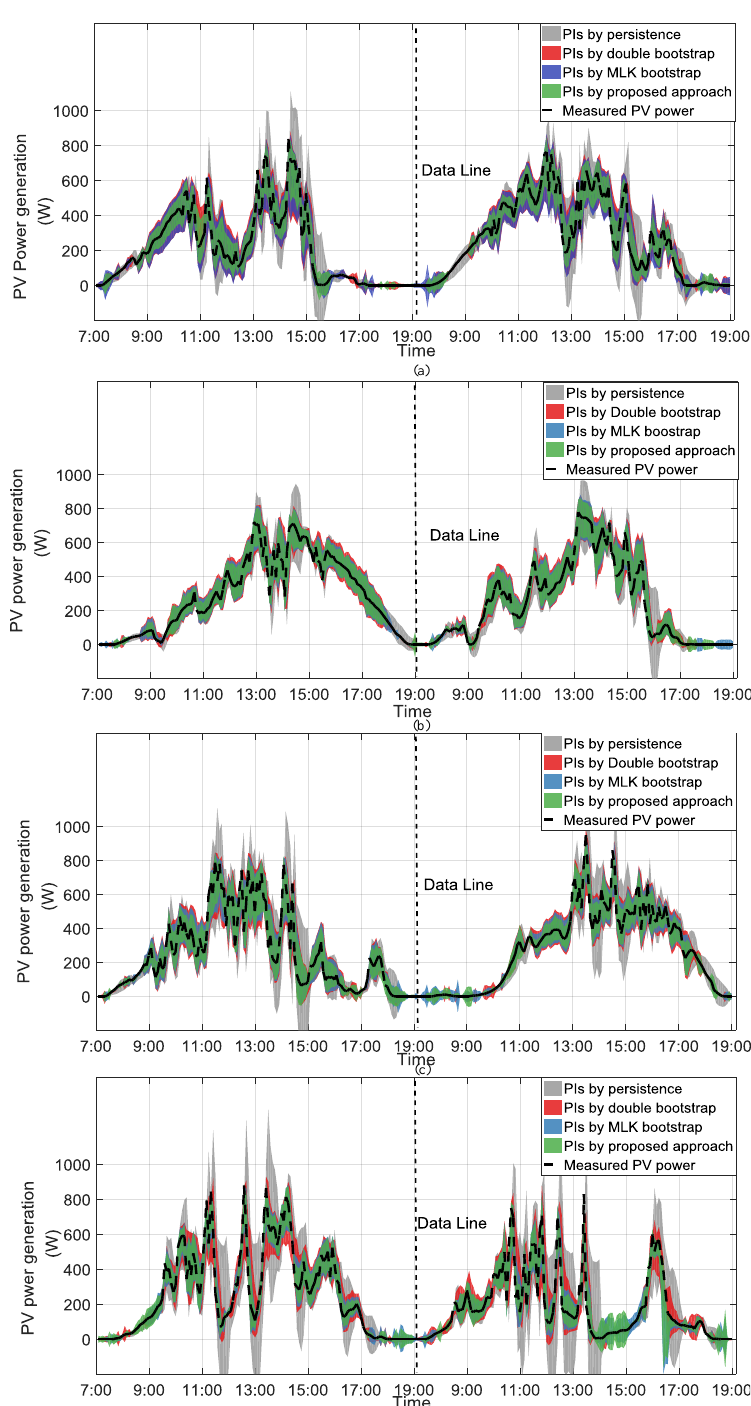
Figure 4. The 5-min ahead PV power forecasting results of four seasons in Singapore: ( a ) northeast monsoon sunny conditions; ( b ) Inter monsoon (NS); ( c ) southwest monsoon; and, ( d ) Inter monsoon (SN) (PIs constructed by proposed model, double bootstrap, MLE-bootstrap and PeEn respectively) with 90% confidence